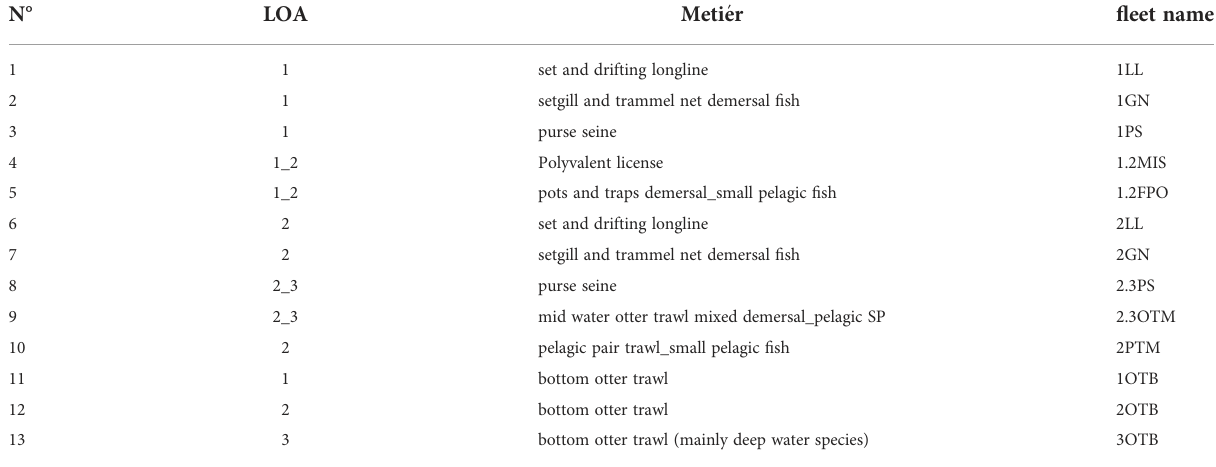
TABLE 2 List of the fl eet segments considered by the combination of vessel size (i.e. length overall =LOA) and fi shing gear. N°